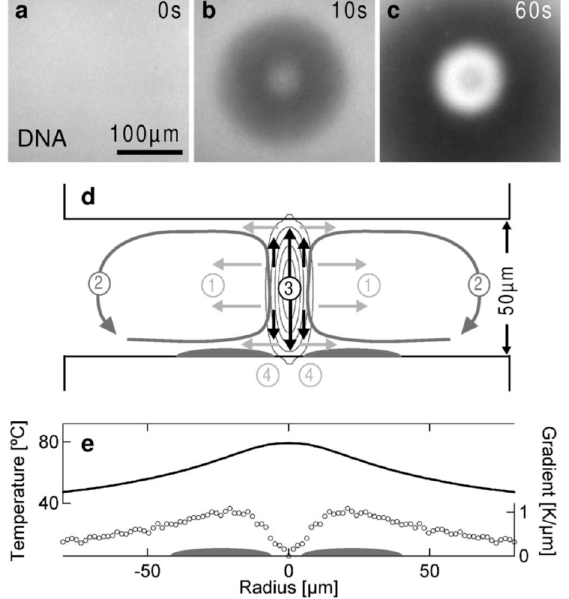
Figure 13. Mechanism of the thermophoretic trapping (TPT) technique for concentrating DNA. ( a ) Initial DNA distribution without any heating; ( b ) fast DNA depletion due to thermophoresis; ( c ) DNA concentration due to the combined effect of thermophoresis and thermal convection; ( d ) the TPT is a synergistic effect of lateral thermophoresis (1)/(4), axial thermophoresis (3) and convection (2); ( e ) the measured lateral temperature distribution around the heating spot. Reprint from Ref. [162].